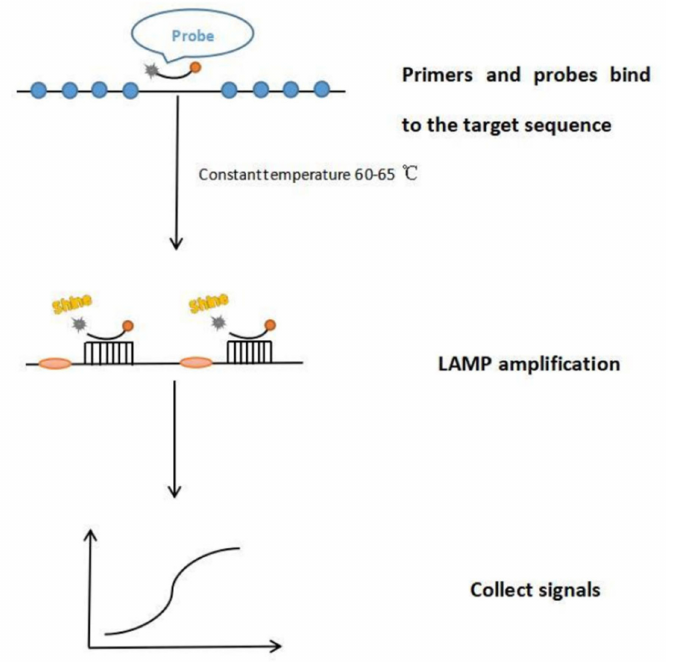
Figure 2. The process diagram of LAMP. Step 1, bind primers and probes to the target sequence. Step 2, amplify LAMP. Step 3, Collect